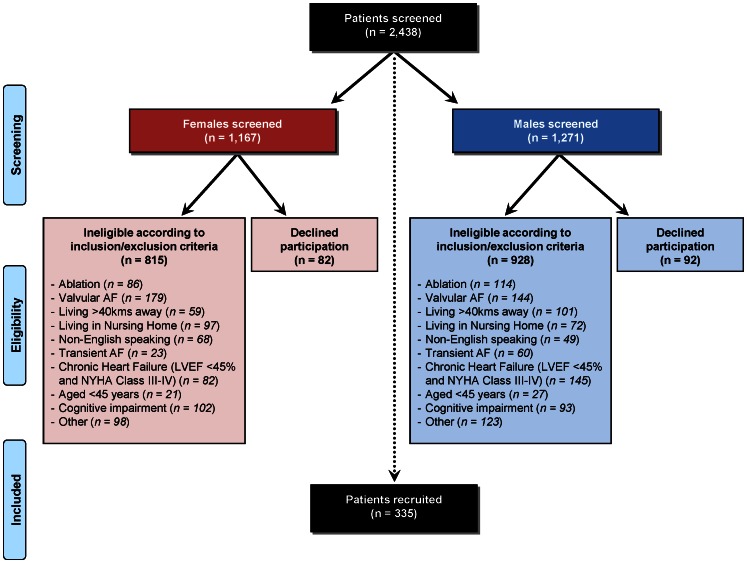
Flow chart of SAFETY recruitment stratified by gender.